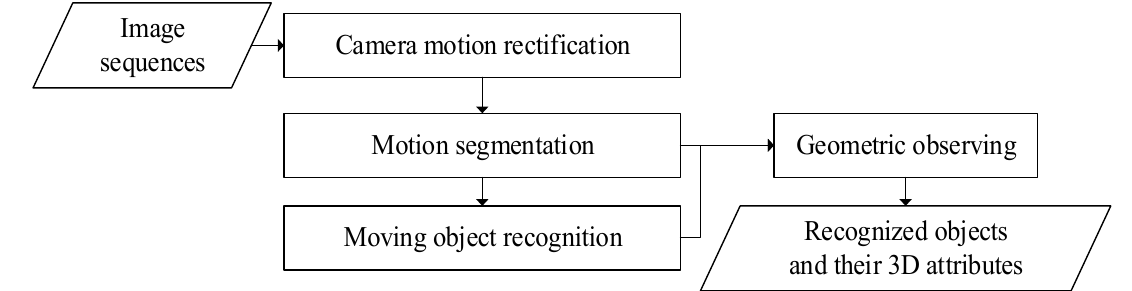
Figure 1. Block diagram of the proposed scheme.